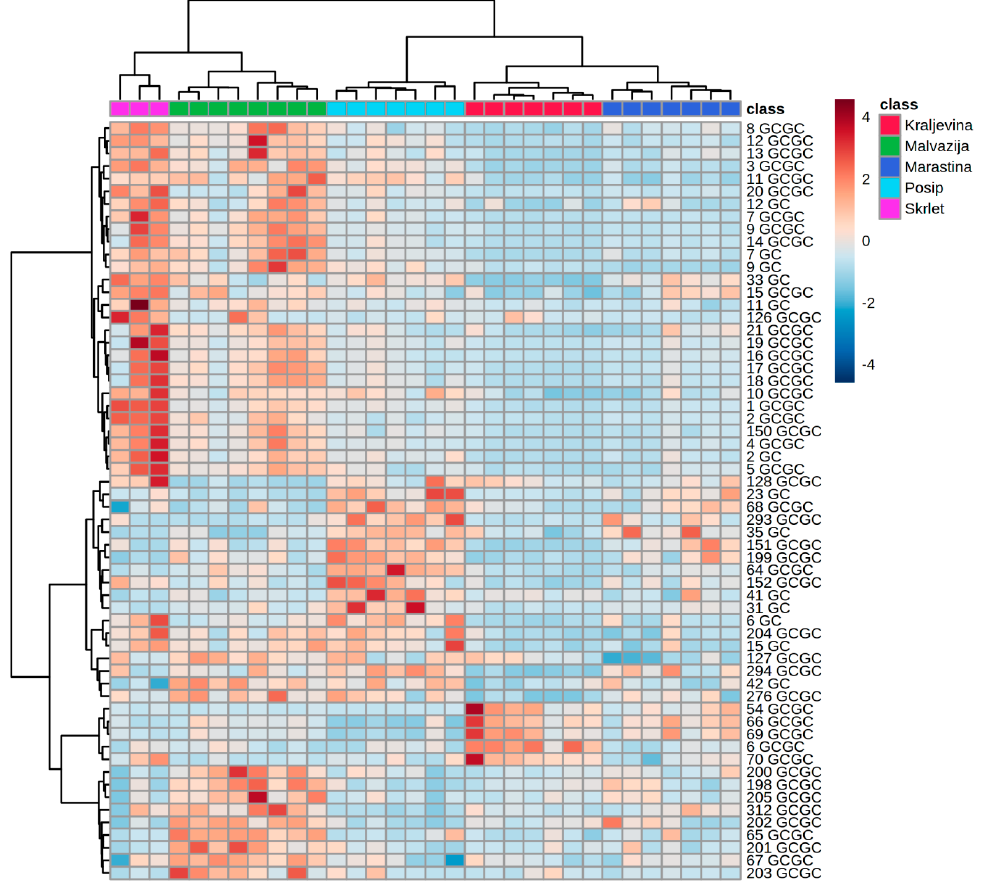
Figure 2. Hierarchical clustering analysis performed using volatile aroma compound profiles of Croatian monovarietal wines obtained by GC-MS and GC×GC-TOF-MS analysis. The heatmap was generated using 60 most significant compounds (the highest F -ratios). The rows in the heatmap represent compounds and the columns indicate samples. Compounds are designated by numbers which correspond to those in Table 1 (GC, i.e., GC-MS) or in Table 2 (GCGC, i.e., GC×GC-TOF-MS). The colors of heatmap cells indicate the abundance of compounds across different samples. The color gradient, ranging from dark blue through white to dark red, represents low, middle, and high abundance of a compound.